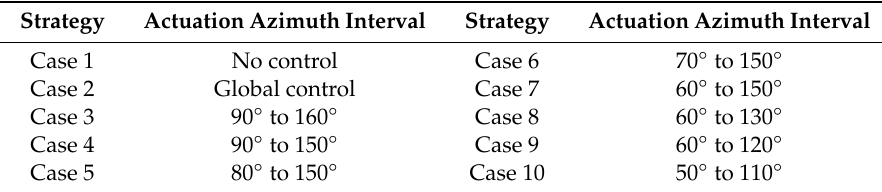
Table 3. Strategies of plasma actuation control.